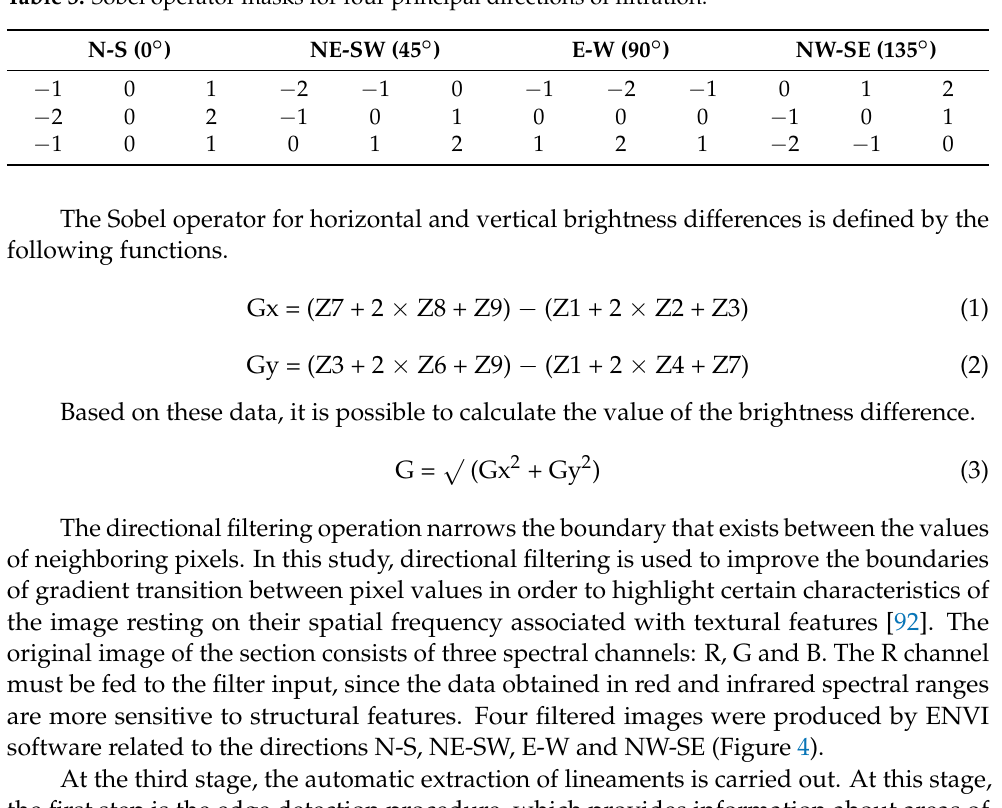
Table 3. Sobel operator masks for four principal directions of